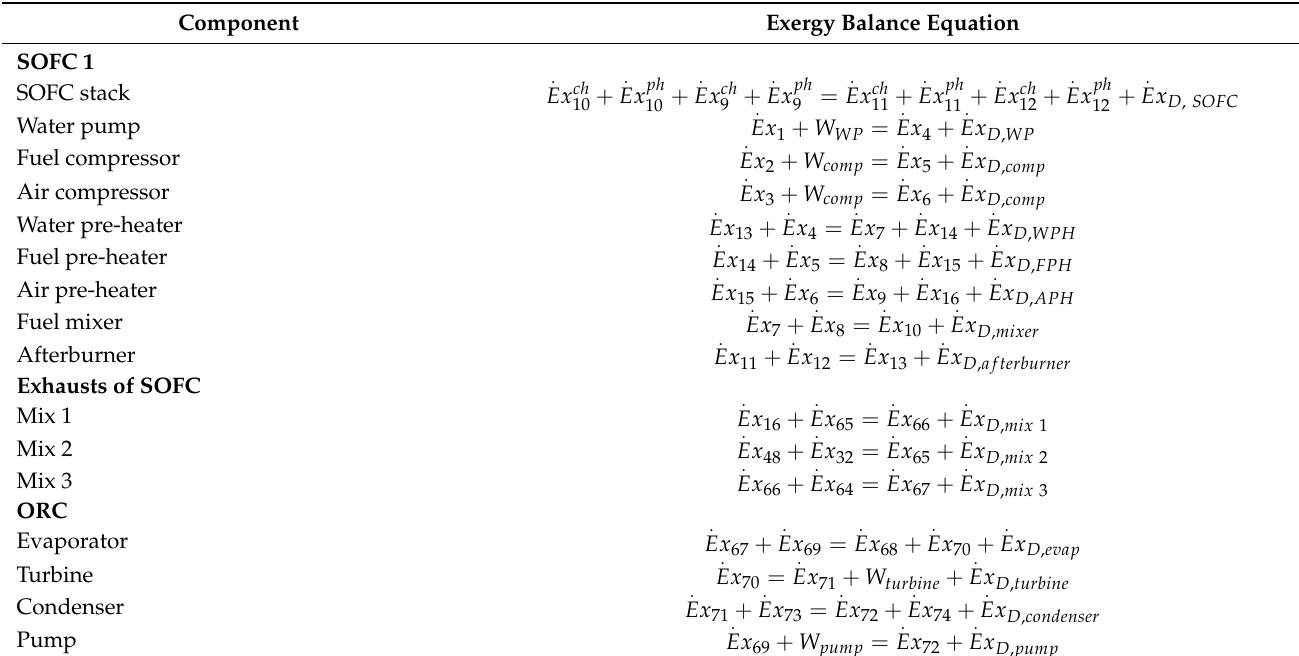
Table 1. Exergy balance equations for the current integrated system.